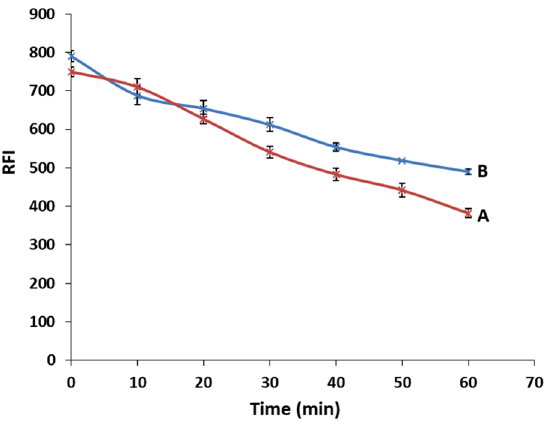
Figure 7: Effect of different exposure time with: (A) 2 M NaOH and (B) 2 M HCl on the RFI of SOT (260.0 ng/mL) at room temperature